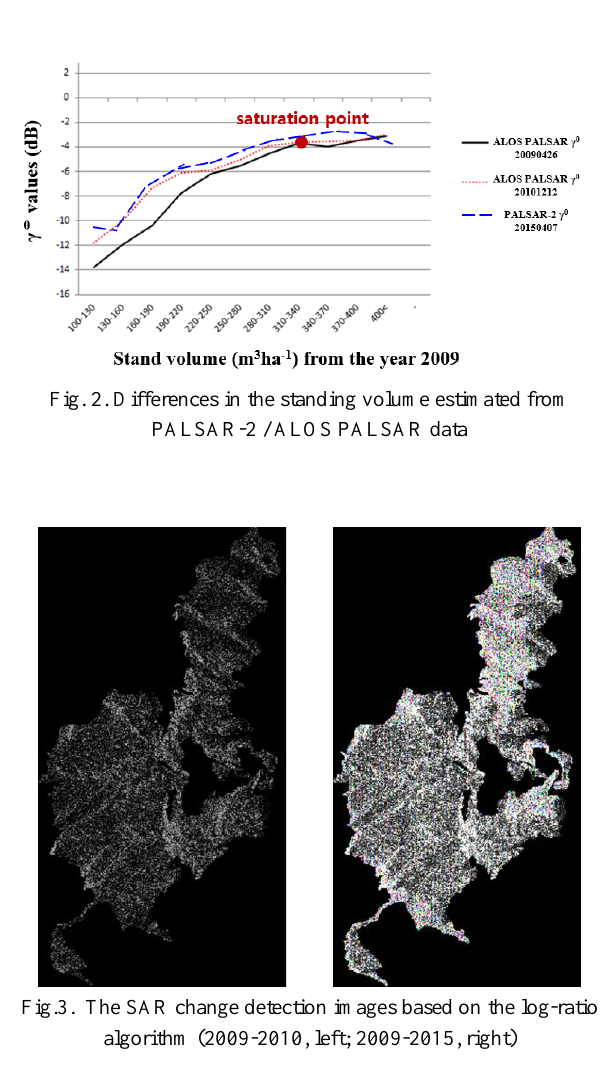
Fig.3. The SAR change detection images based on the log-ratio algorithm (2009-2010, left; 2009-2015, right)